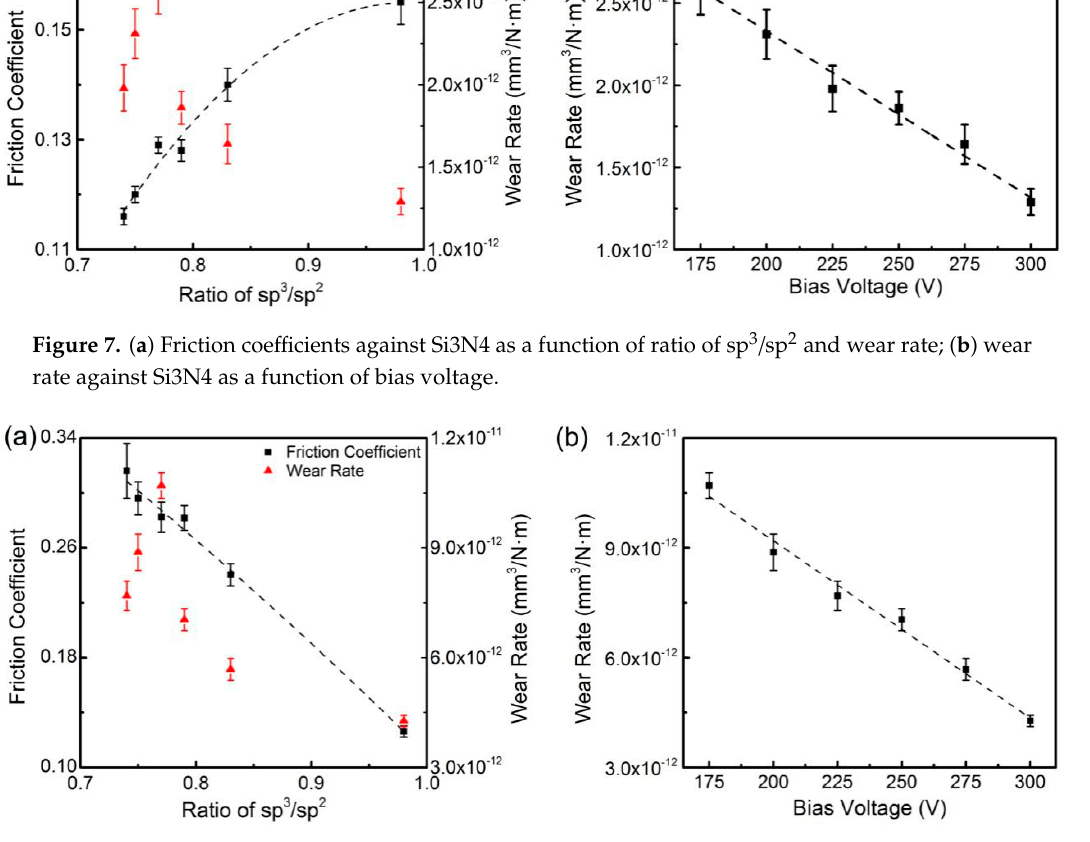
Figure 8. ( a ) Friction coefficients against Ti6Al4V as a function of the ratio of sp 3 /sp 2 and wear rate; ( b ) wear rate against Ti6Al4V as a function of bias voltage.